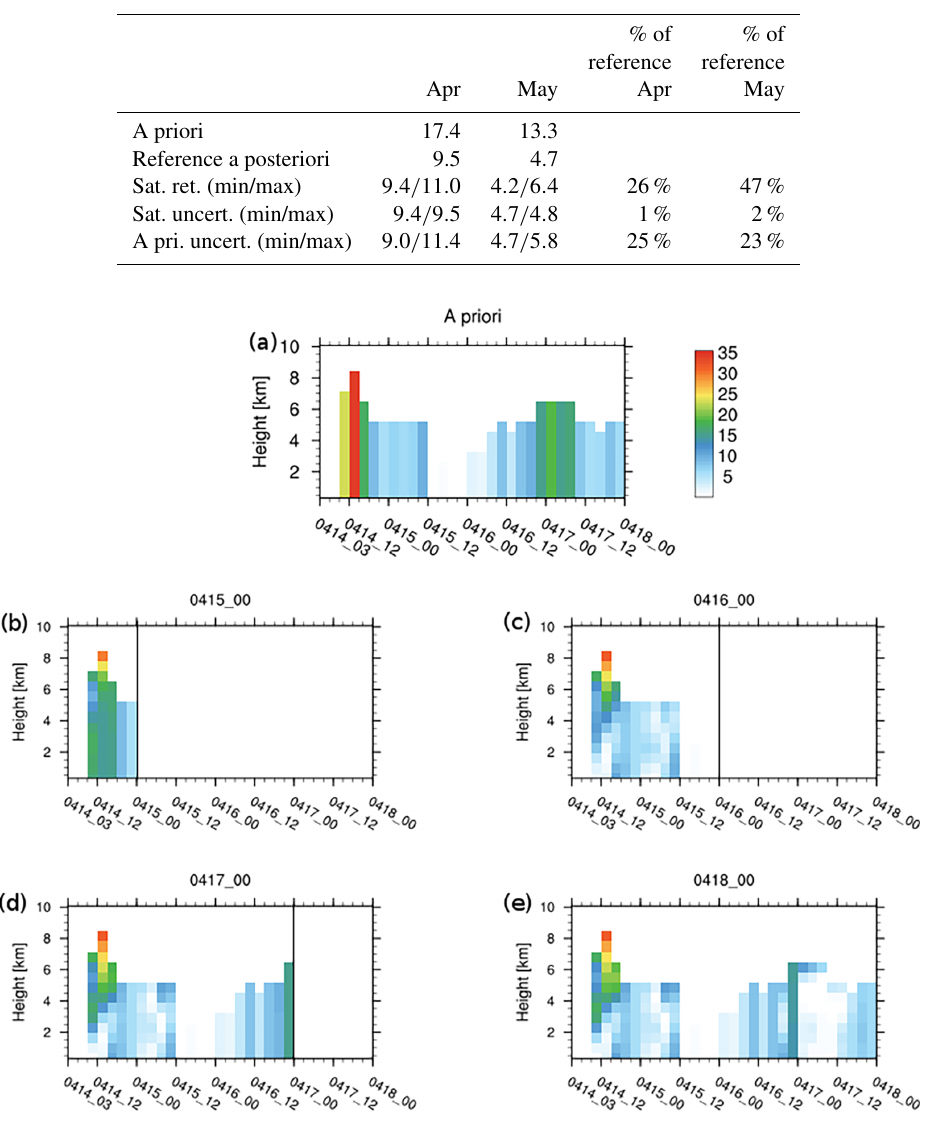
Figure 6. Vertical emission distributions over the volcano with 3h resolution, given in kgm − 1 s − 1 . A priori source term (a) and a posteriori source terms (b–e) by using satellite observations up until the start of the forecast time (vertical black line) over the April period. Only the a posteriori term for the 00:00UTC forecasts are